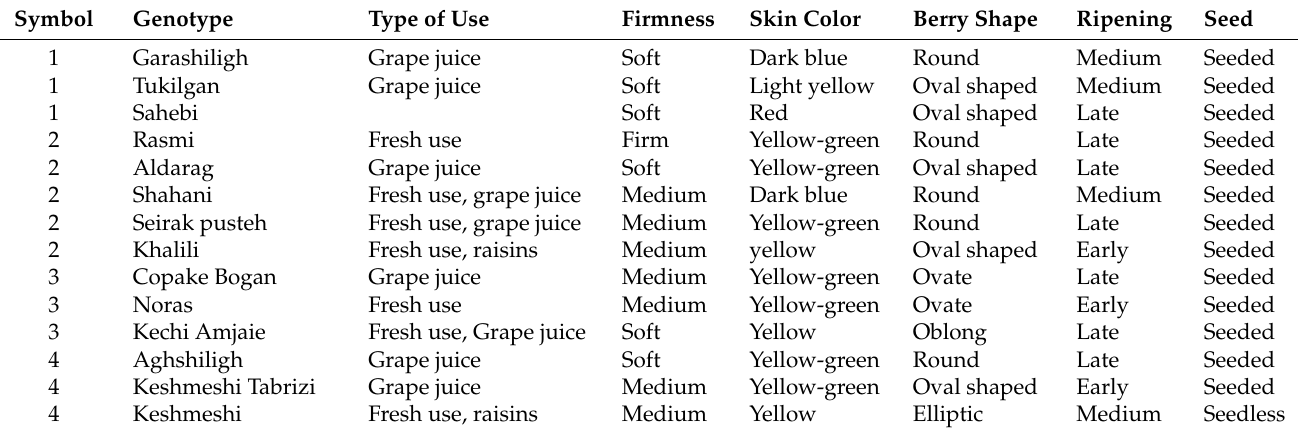
Table 1. Name, characteristics, and grouping of grapevine cultivars used in the present